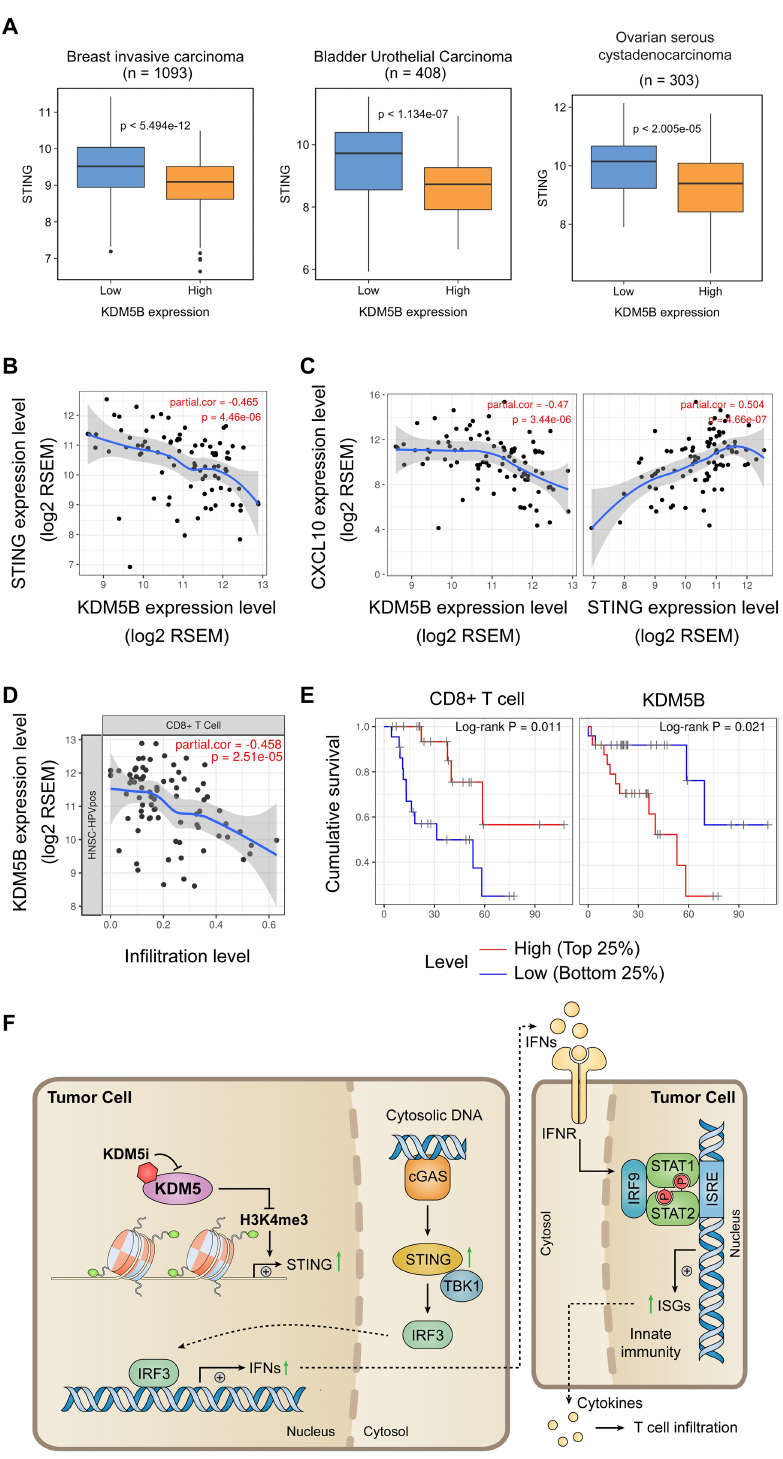
Fig 7. KDM5B is negatively associated with STING expression, CD8 + T-cell infiltration, and clinical outcome. (A) Anticorrelation between expression of KDM5B and STING in TCGA cancer samples. Normalized STING levels in “KDM5B low” and “KDM5B high” samples of breast invasive carcinoma, bladder urothelial carcinoma, and ovarian serous cystadenocarcinoma from the TCGA datasets. The numerical values used to generate these graphs are available in S1 Data. (B) Correlation between KDM5B and STING in HPV + head and neck tumors. n = 79. (C)